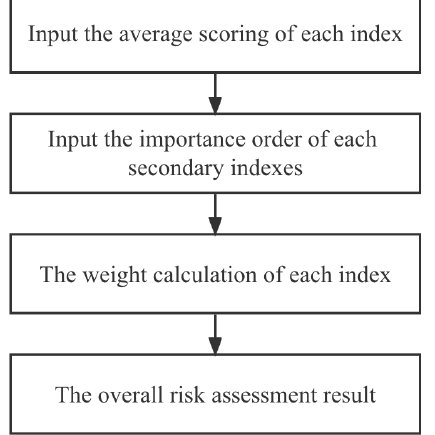
Figure 6. Basic process of the proposed risk assessment